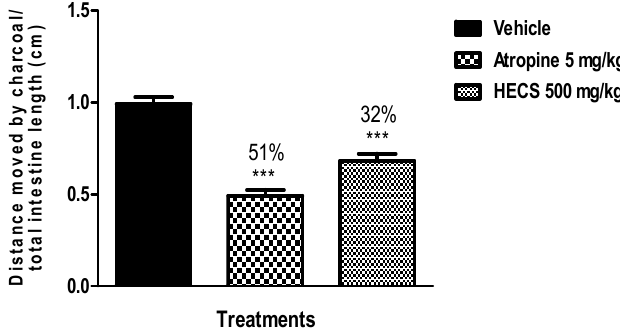
Figure 5. Effect of the hydroalcoholic extract of C. sicyoides— HECS (500 mg/kg, p.o.) on intestinal transit induced by carbachol (muscarinic receptor agonist). The results are expressed as the mean ± S.E.M., and statistical significance was determined by ANOVA followed by Dunnett’s test; *** p < 0.001 compared to the control group (vehicle). The numbers in percentage in the figure corresponds to the reduction of charcoal movement in relation to the control group treated with vehicle ( n = 8).